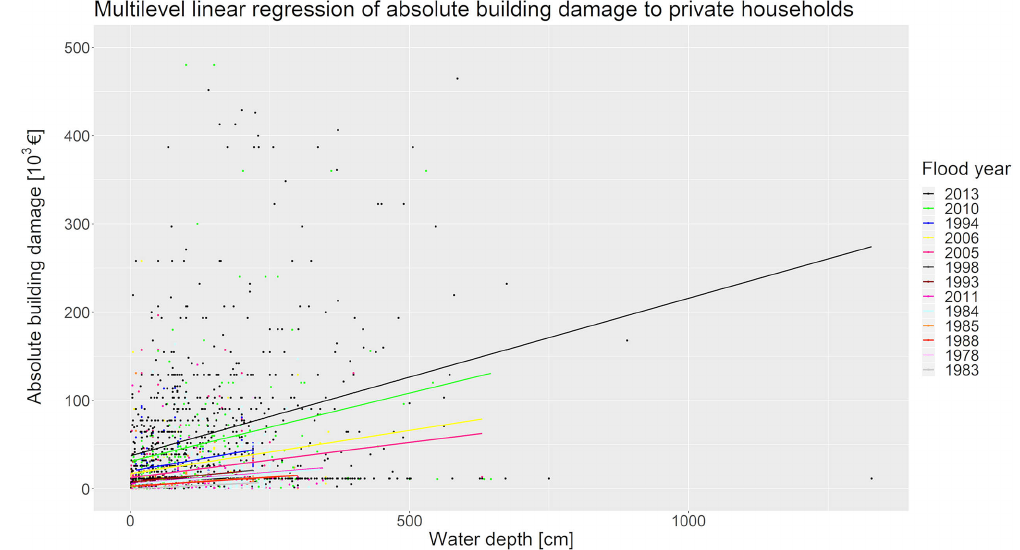
Figure 5. Scatter plot of water depth and absolute damage to buildings in the private household sector including multilevel linear regression lines. Regressions are carried out on the basis of the following samples sizes: n = 207 (1978), n = 226 (1983), n = 785 (1984), n = 354 (1985), n = 124 (1988), n = 55 (1993), n = 78 (1994), n = 36 (1998), n = 286 (2005), n = 146 (2006), n = 243 (2010), n = 90 (2011), n = 984 (2013).